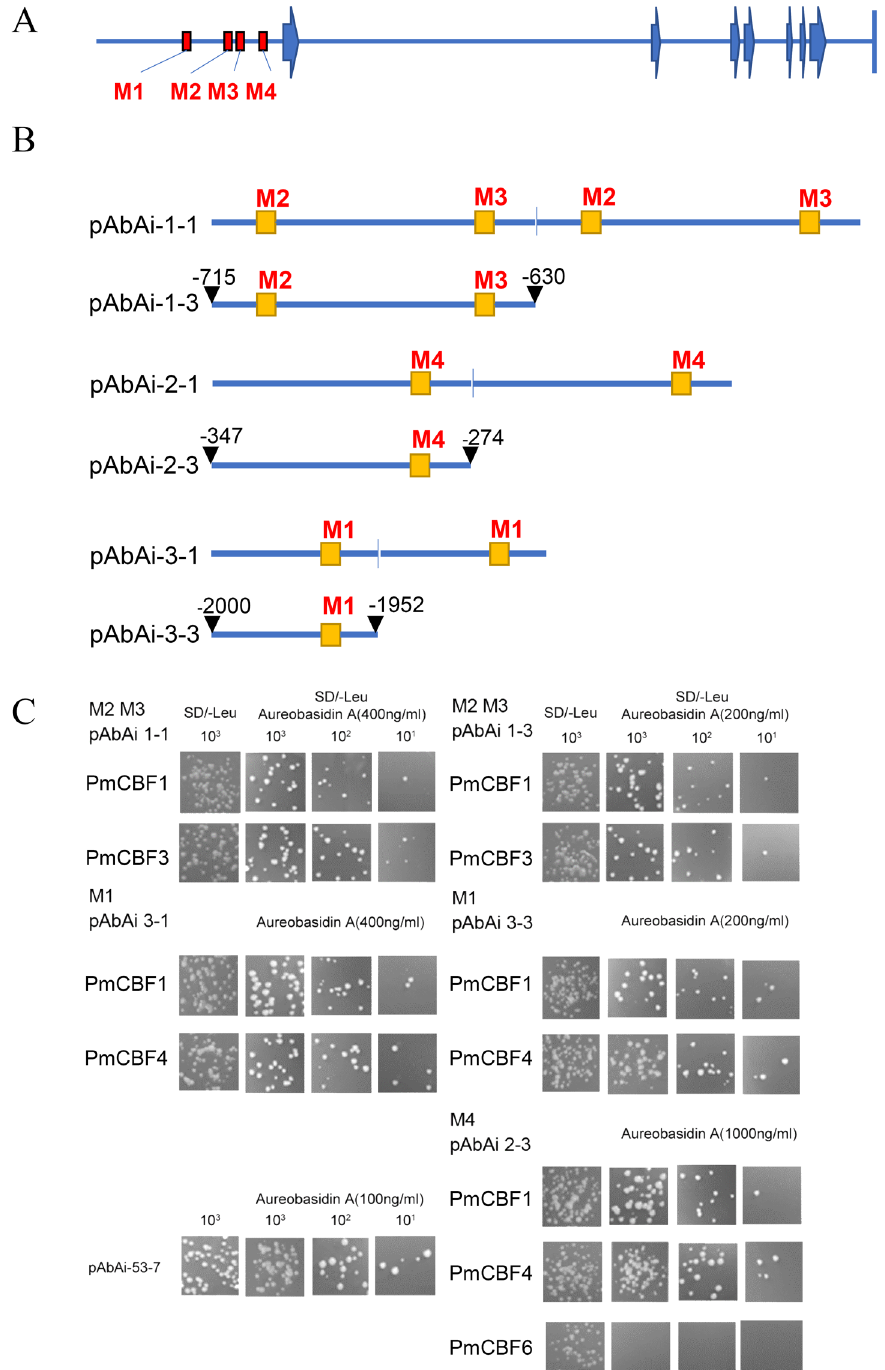
Figure 1. PmCBFs bind the promoter of PmDAM6 in vivo . ( A ) The genomic structure and promoters of PmDAM6 and the CBF-binding sites in were marked by red blocks. ( B ) The designed baits in Y1H, the whole promoter was split into three part about 100 bp. ( C ) The results of Y1H assays between PmCBFs and the